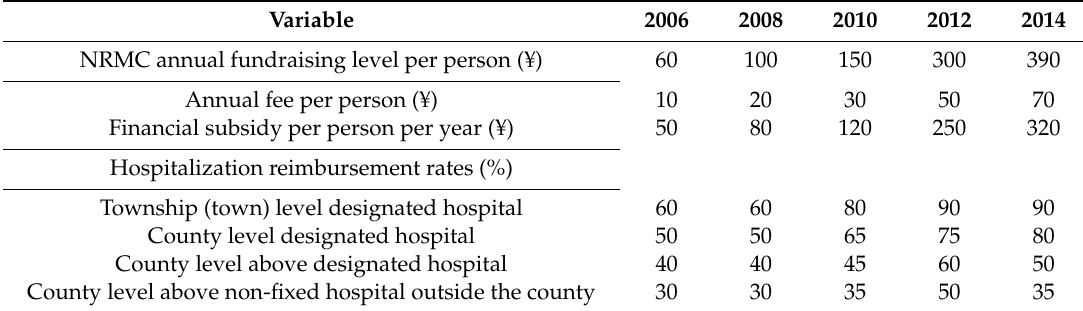
Table 1. Financing level and compensation ratio of new rural cooperative medical care from 2006 to